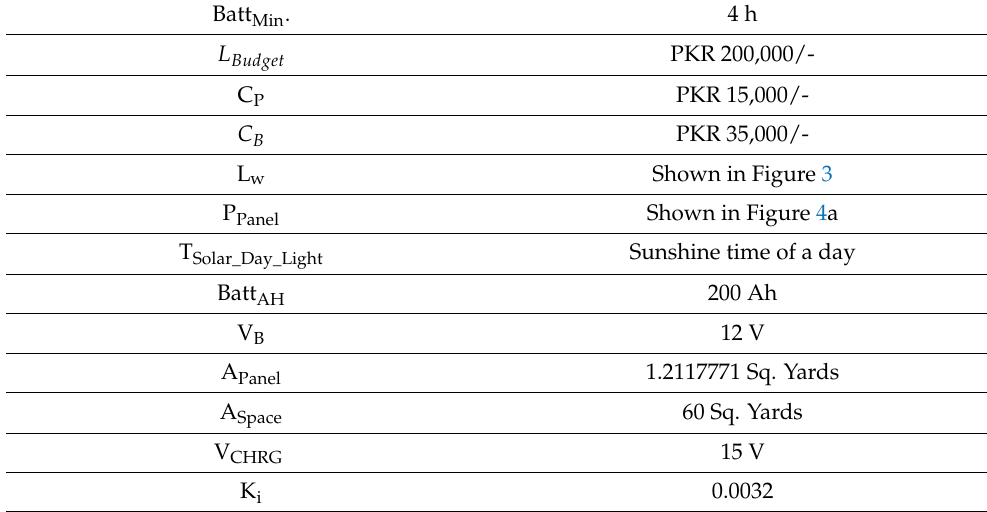
Table 2. Model parameters and settings.